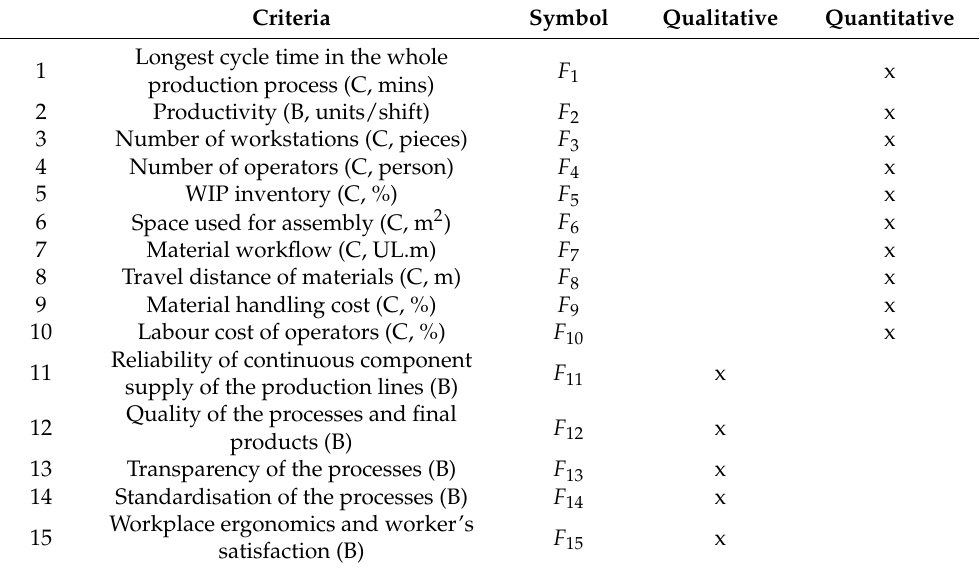
Table 10. List of criteria.